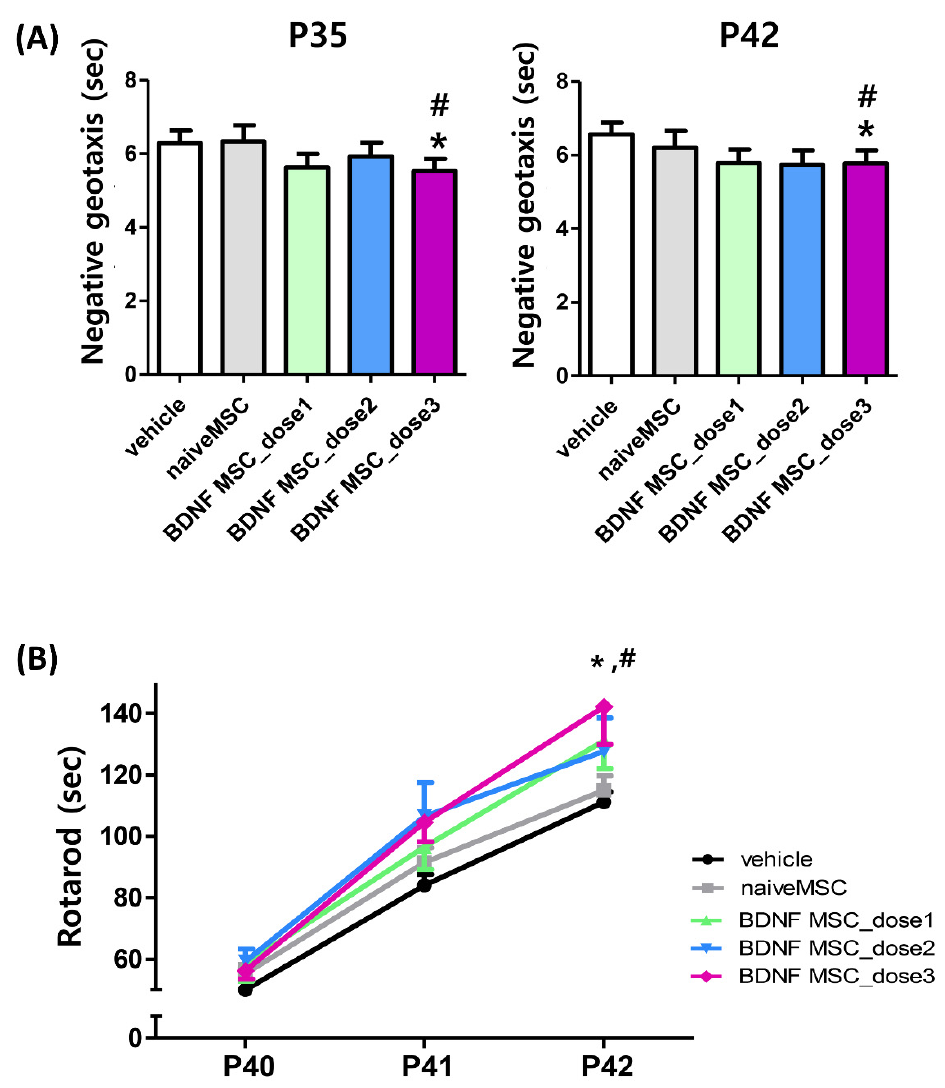
Figure 7. Sensorimotor behavior function after hypoxic ischemic injury and MSC transplantation. Sensorimotor functional outcomes on the negative geotaxis test at P35 (4 weeks after modeling) and at P42 (5 weeks after modeling) ( A ) and rotarod test ( B ) on P40–42 in each group. Data are expressed as mean ± standard error of the mean. * p < 0.05 compared to the HI + vehicle control, # p < 0.05 compared to the HI + naïve MSCs. Abbreviations: vehicle, HI + vehicle control, naïve MSCs; HI + naïve MSCs, BDNF MSC_dose1; HI + BDNF-eMSCs at 1 × 10 4 cells dose; BDNF MSC_dose2; HI + BDNF-eMSCs at 5 × 10 4 cells dose; BDNF MSC_dose3.